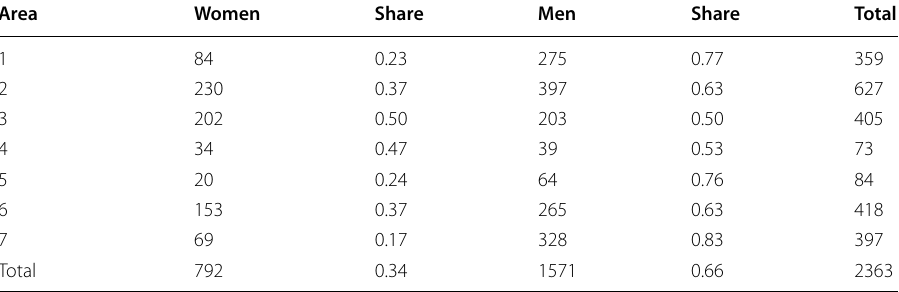
Table 11 Number of women and men in each Area: sample Area